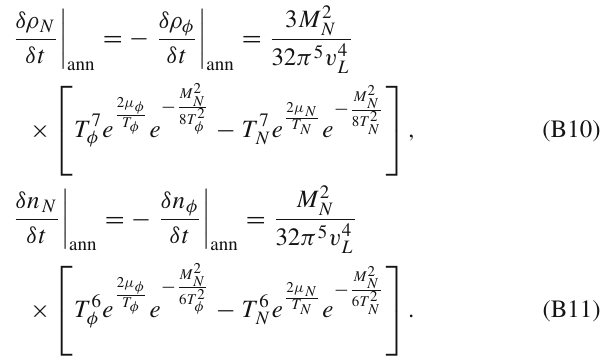
Fig. 9 Relevant rates normalized to the expansion rate for the case of M N = 1 GeV and v L = v H = 246 GeV which yields (cid:2) N BBN In red we show the relevant rates involving majorons and in blue we show the rate of N production from the SM bath [111] (for T < 5